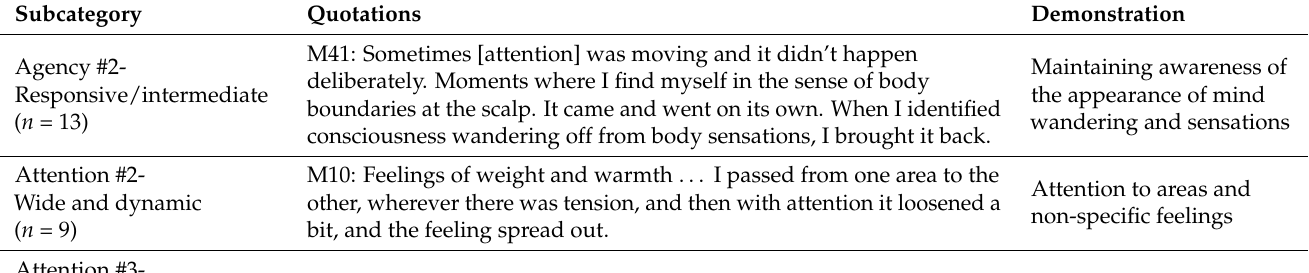
Table 4. Examples of less prevalent SB+ experiences.